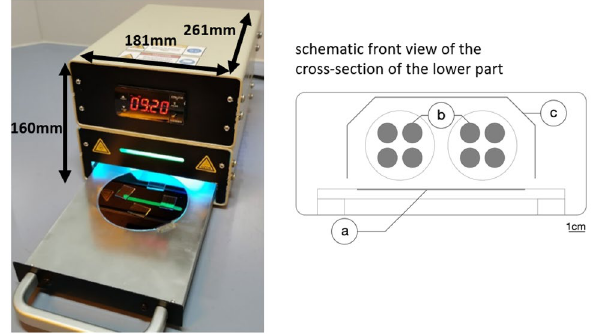
Fig. 1 Left side: photograph of the equipment in a fume hood with substrate carrier tray open. The upper part houses the electronics, while the lower part acts as the reaction chamber; right side: cross- sectional view of the reaction chamber (lower part): a substrate car- rier, b sterilisation lamps, c reflector made of anodized